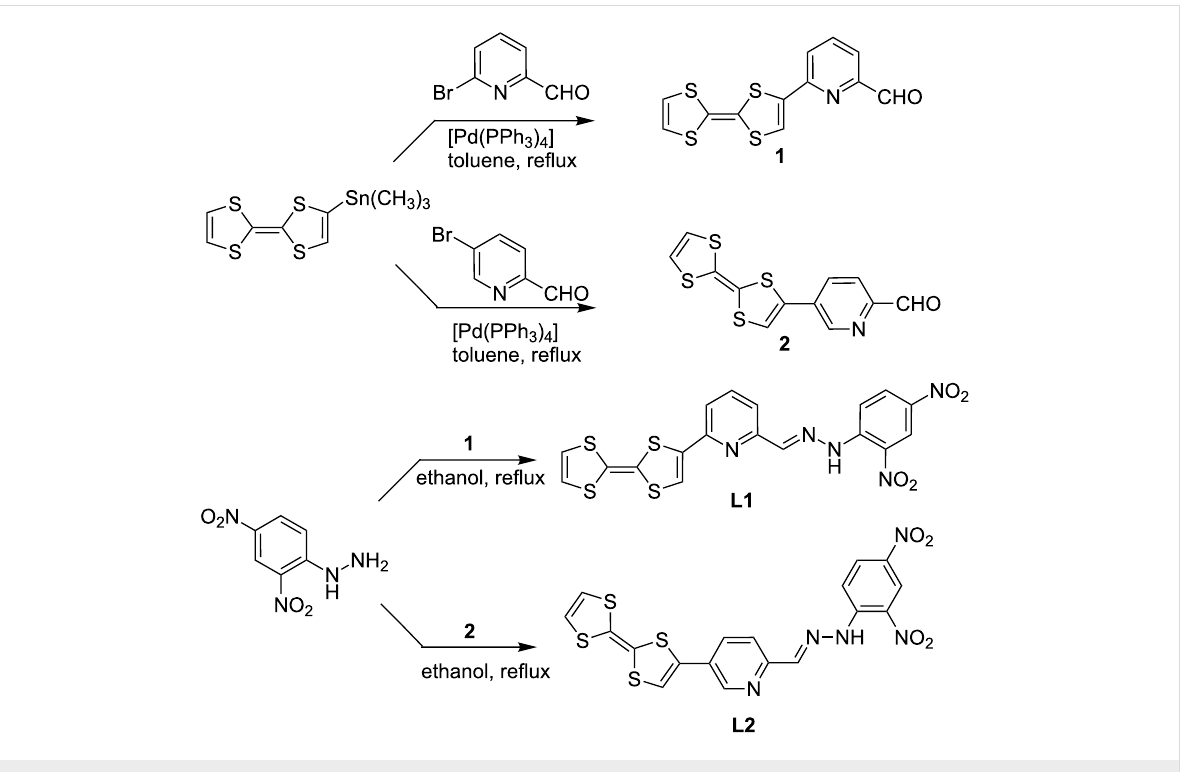
Scheme 2: Synthetic scheme for TTF-based azine ligands L1 and L2